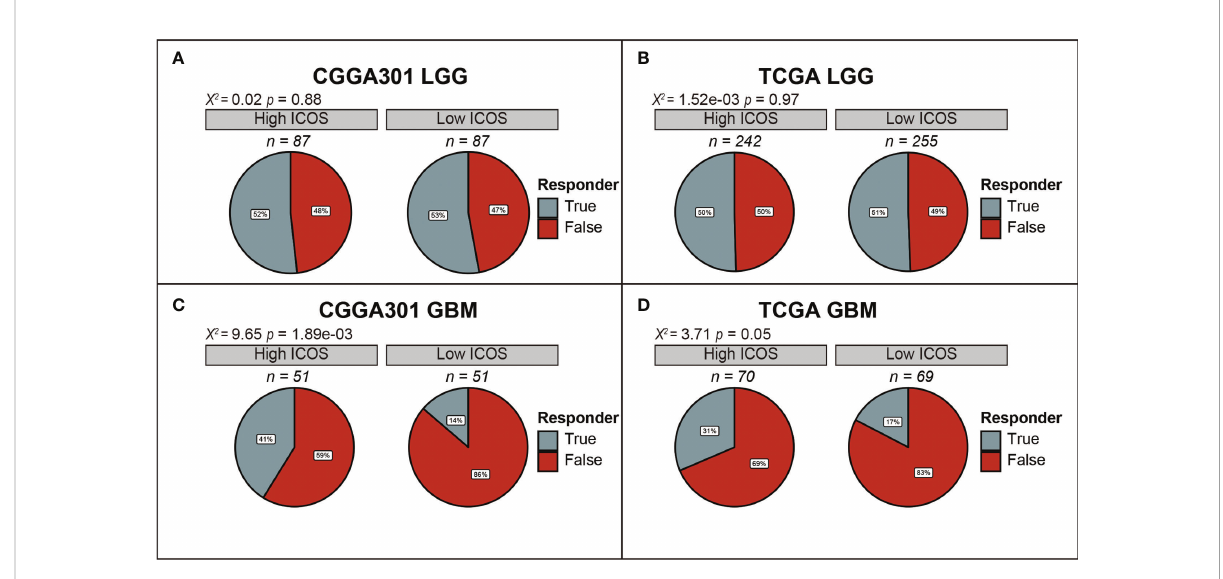
FIGURE 6 Comparison of response to immunotherapy between high-ICOS and low-ICOS groups in CGGA301 and TCGA datasets. (A) Response to immunotherapy in CGGA301 lower-grade glioma. (B) Response to immunotherapy in TCGA lower-grade glioma. (C) Response to immunotherapy in CGGA301 glioblastoma. (D) Response to immunotherapy in CGGA301